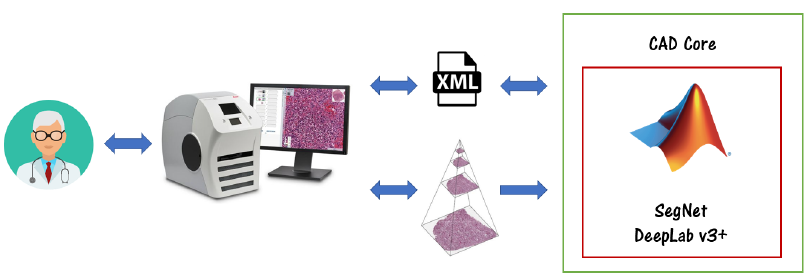
Figure 2. CAD architecture. Physicians can visualize and annotate the WSIs using Aperio ImageScope software. The developed Deep Learning models can interact with ImageScope through an XML